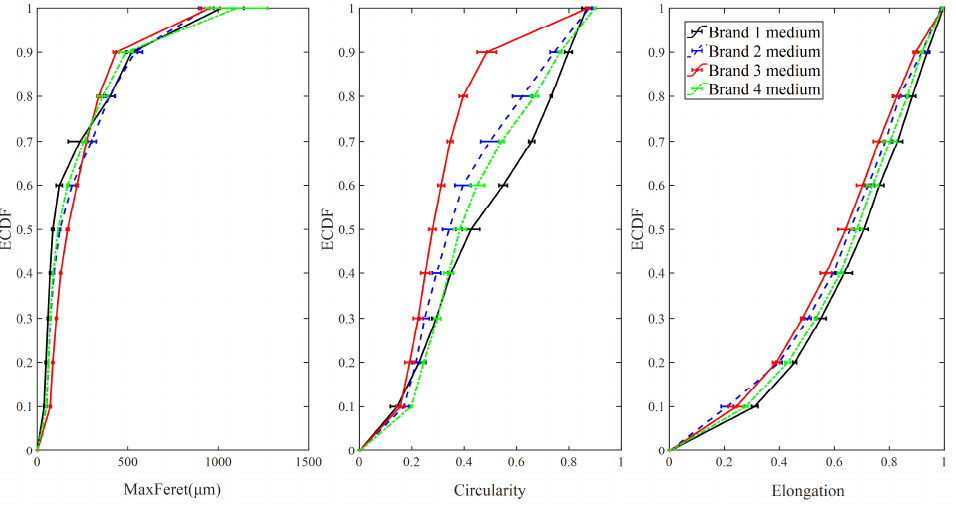
Figure 6. The empirical cumulative distribution function of shape factors for medium sized particles from four different brands of instant whole milk powder (IWMP).